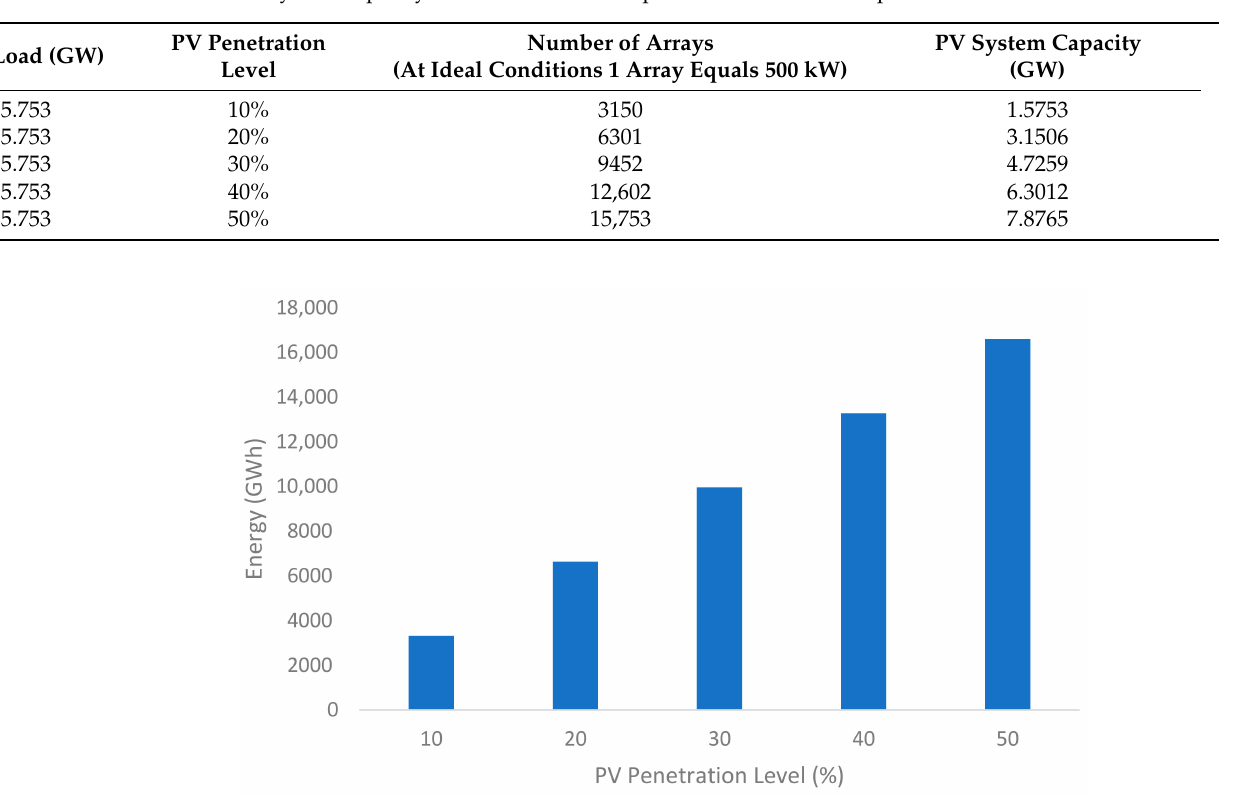
Table 2. PV system capacity based on the desired penetration level to the peak load.